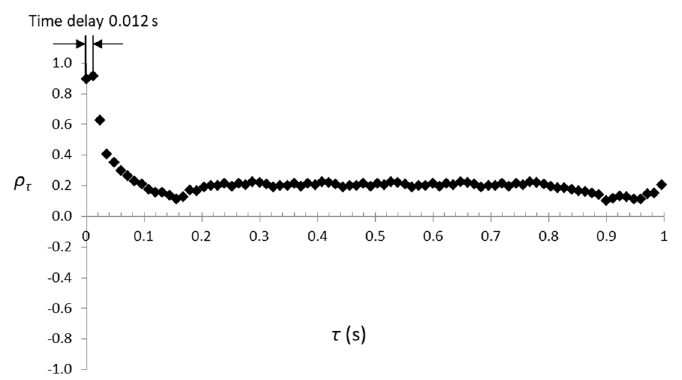
Figure 7. Calculated values of the correlation index for the C1 , C2 capacitors values during 1s slush nitrogen flow.